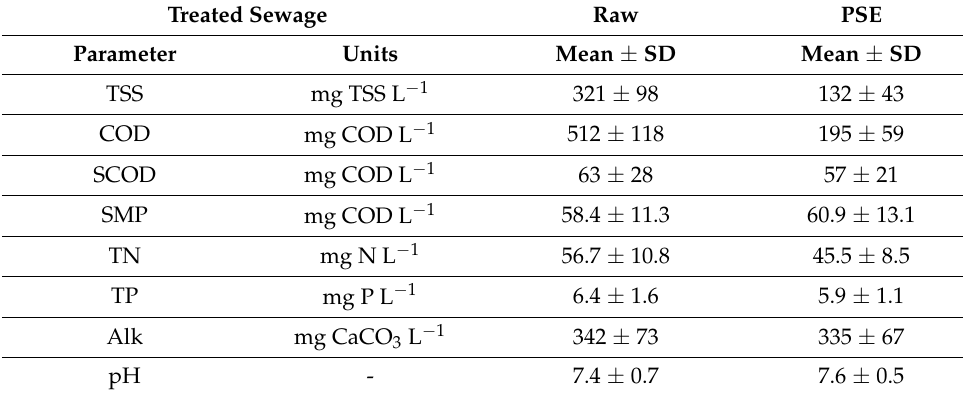
Table 1. Influent municipal wastewater characteristics.